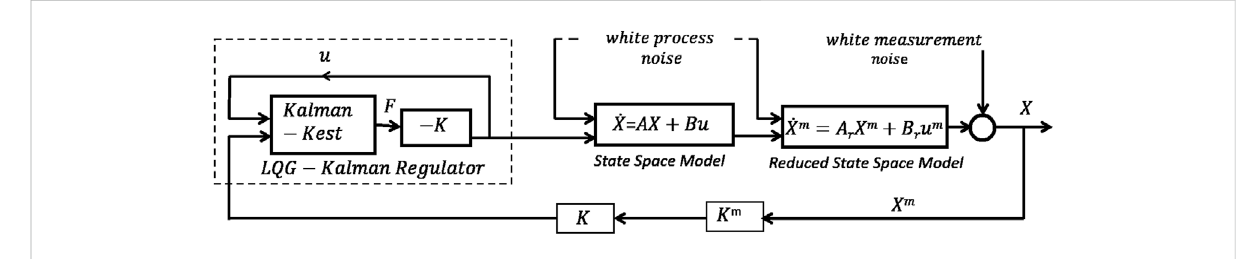
The LQG control with the Kalman fi lter design in the reduced